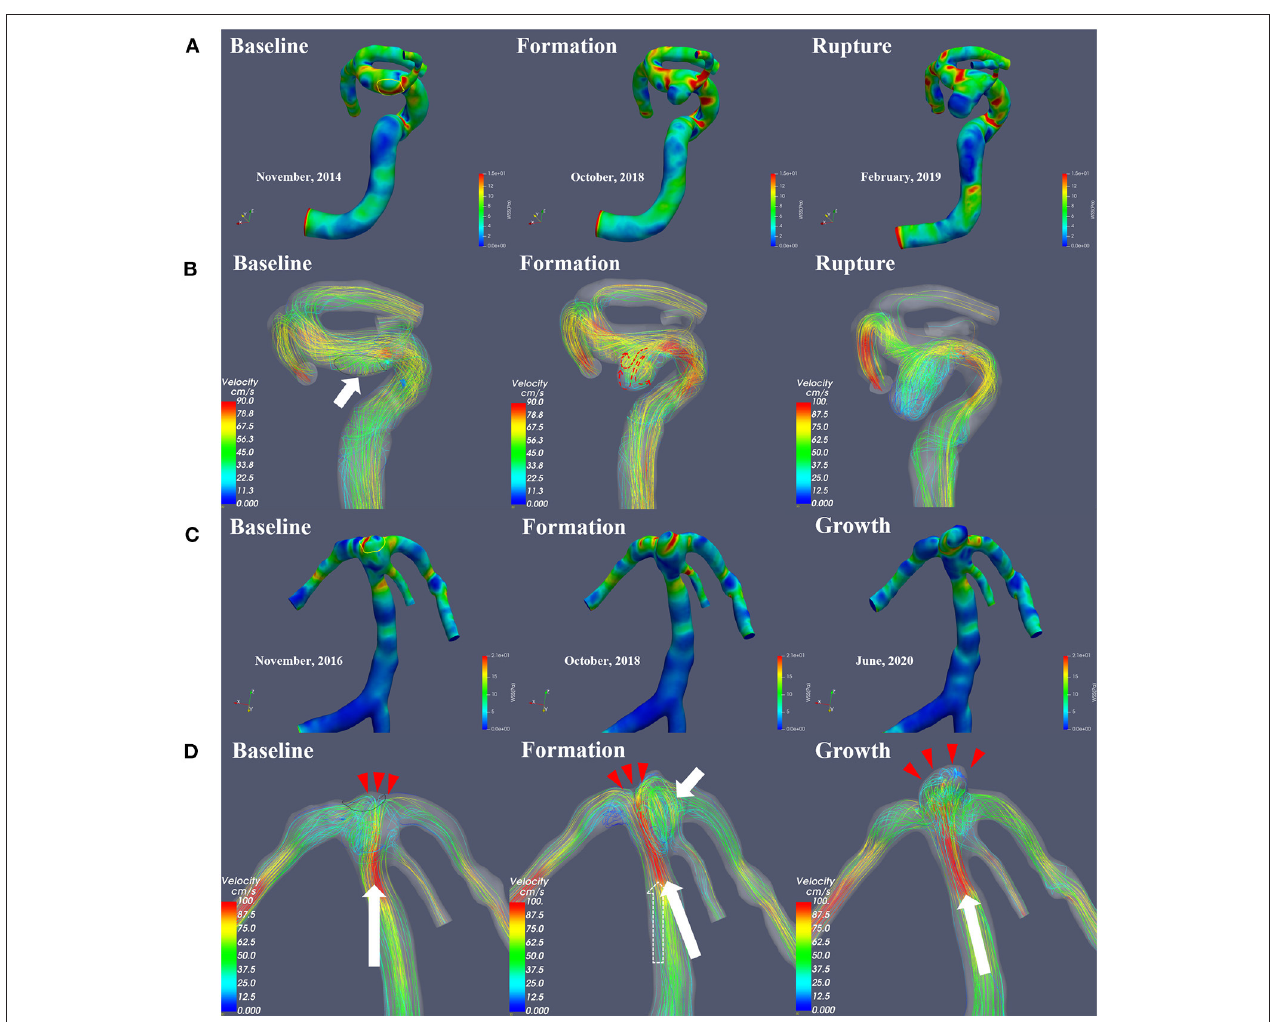
FIGURE 2 | This figure illustrates the change in hemodynamic parameters during the formation, progression and rupture of IAs. The WSS distribution (A,C) and flow velocity profile (B,D) were shown, respectively. The area within the yellow line is the region of aneurysmal formation marked by the registration technique. Prior to aneurysm formation, the regions feature flows with vortex structures ( B , short white arrow). In the impact region ( D , Baseline, red arrows) of the concentrated high-velocity inflow jet ( D , Baseline, long white arrow indicates blood flow direction), a newly formed basilar tip aneurysm was visible on follow-up angiography (D) . Affected by vortex flow after the formation of the aneurysm ( D , Formation, white short arrow), the main direction of flow shifted ( D , Formation, from the original dotted arrow to the long white arrow), causing saccular dilatation in the new impact region ( D , Formation, red arrows), and the size of the aneurysm increased ( D , Growth). A complex multi-vortex flow is associated with future aneurysm growth, and rupture is related to extreme instability and complexity of blood flow